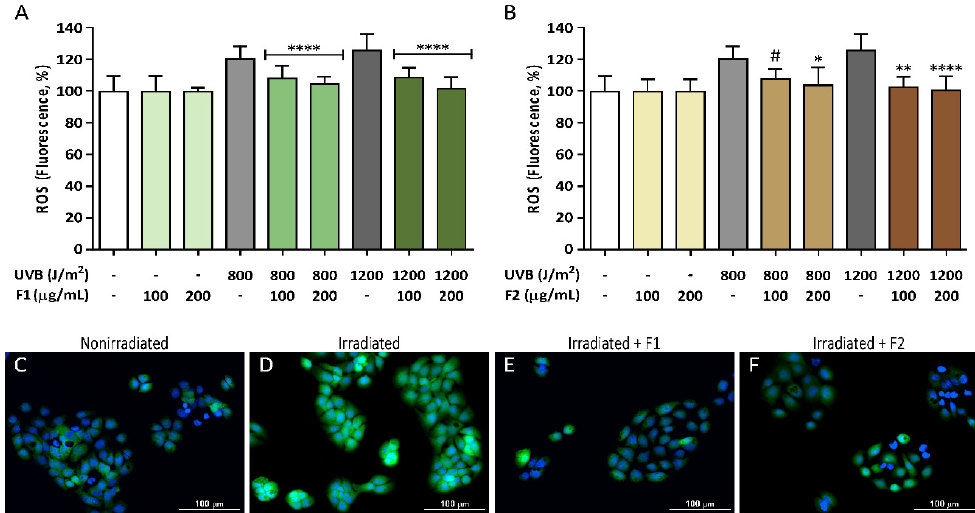
Figure 4. Inhibition of UVB-induced reactive oxygen species (ROS) generation in HaCaT keratinocytes exposed to UVB radiation (800 or 1200 J/m 2 ) by formulations F1 ( A ) and F2 ( B ). Intracellular ROS generation was measured using a H 2 DCF-DA probe, and fluorescence was normalized to the nuclei number. Representative pictures of control nonirradiated HaCaT cells ( C ), control irradiated cells at 1200 J/m 2 ( D ), irradiated cells at 1200 J/m 2 in the presence of F1 (200 µg/mL) ( E ), and irradiated cells at 1200 J/m 2 in the presence of F2 (200 µg/mL) ( F ) are shown. The scale bar represents 100 µm. The data are expressed as the mean ± SD. * ( p < 0.05), ** ( p < 0.01), or **** ( p < 0.0001) indicate significant differences at the same UVB dose in irradiated and nontreated cells, while # ( p < 0.05) indicates significant di ff erences between cells treated with the other formulation at the same concentration with the same UVB irradiation